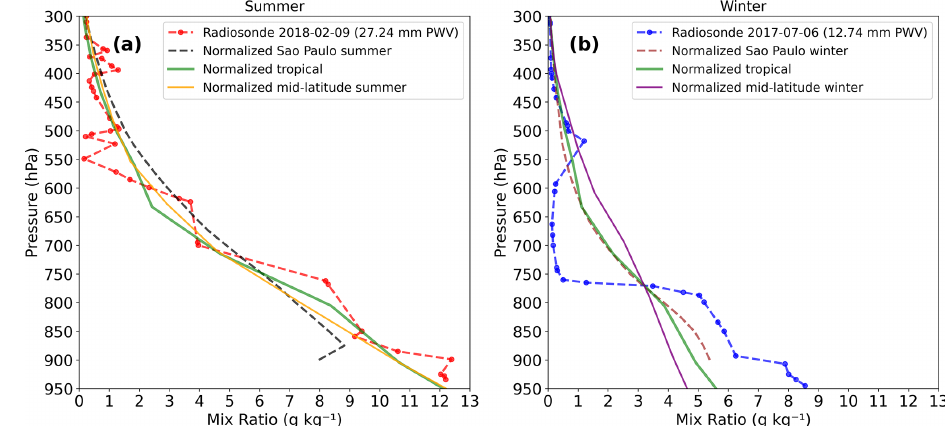
Figure 6. Vertical water vapor mixing ratio profiles normalized to the radiosonde integral PWV values for ( a ) a summer day (9 Febru- ary 2018) and ( b ) a winter day (6 July 2017). Atmospheric profile coloring is the same as in Fig.